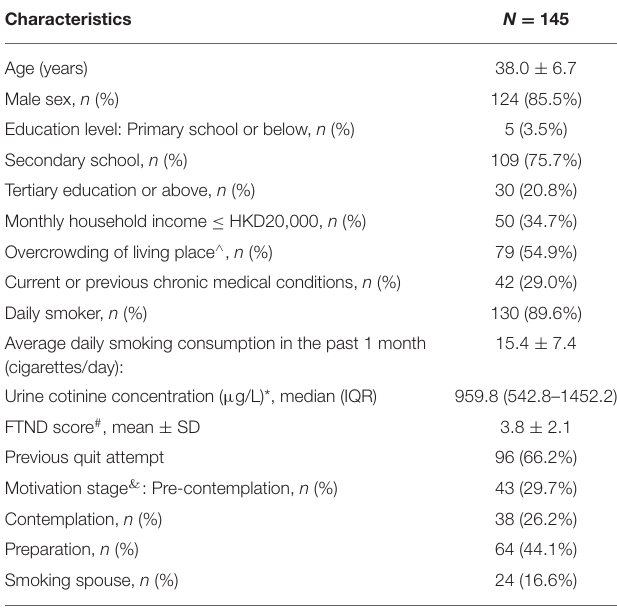
TABLE 1 | Demographic characteristics and smoking history of the smoking parents ( N = 145).